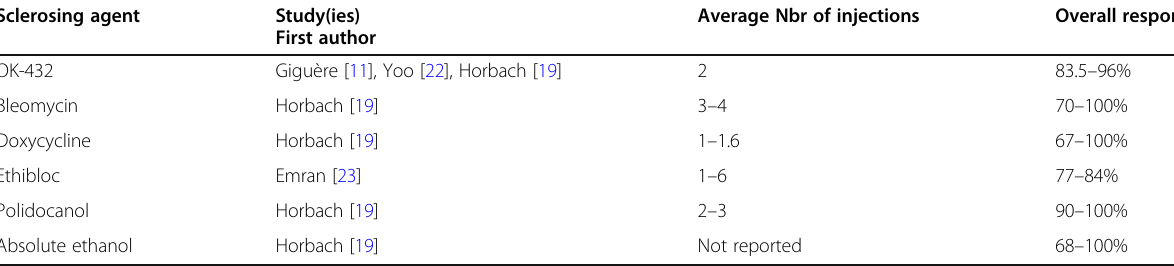
Table 5 Response to sclerotherapy according to sclerosing agents Sclerosing